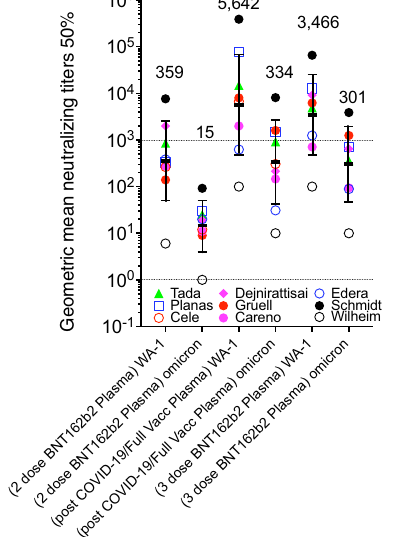
19 plus BNT162b vaccine (Vax-CCP). c Nine additional studies looked at the same vaccine conditions in the fi rst 5 comparing WA-1 nAb to Omicron BA.1 nAb (geo- metric standard deviation for error bars). Haveri et al. missing 2-dose BNT162b, Bekiliz et al and Rossler et almissing 3-dose BNT162b, Lusvarghiet al. missing post COVID-19/post full vaccine. Source data are provided as a Source Data fi